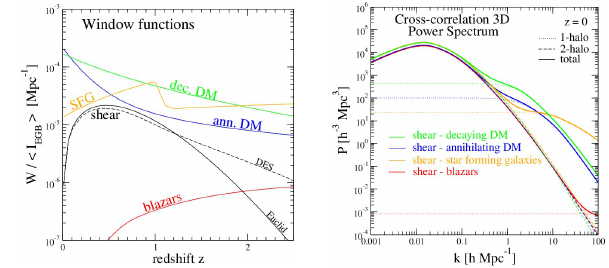
Figure 2: Left : Window functions vs. redshift. For γ -ray sources we consider the flux above 1 GeV nor- malized to the total EGB intensity measured by Fermi- LAT. Right: Three-dimensional PS of cross-correlation shear/ γ -rays at z = 0. This figure is taken from Camera et al.